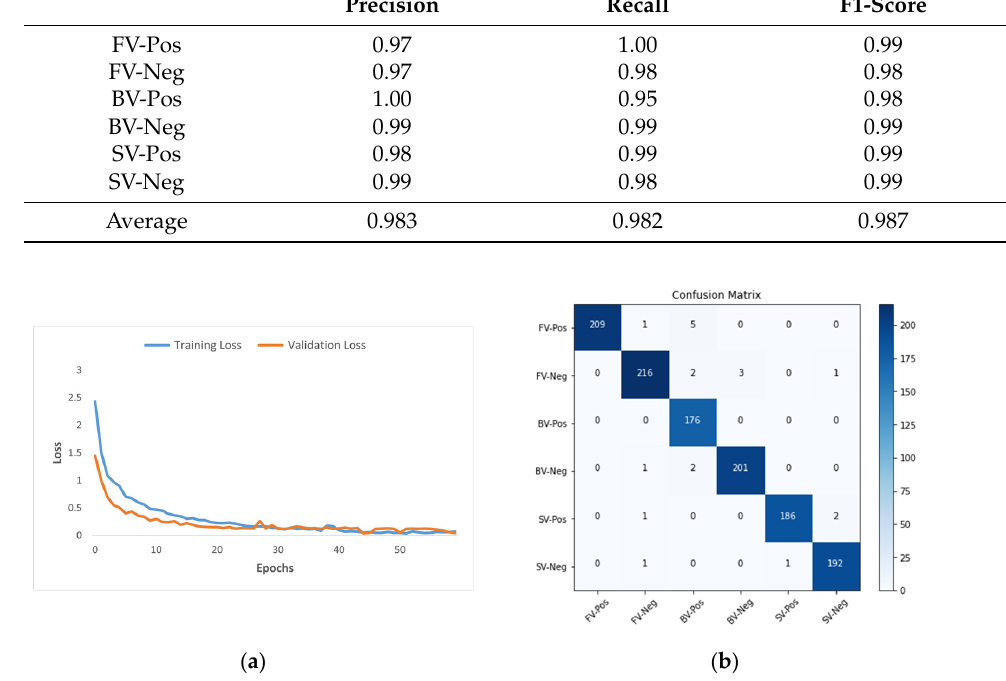
Table 18. Precision, recall, and F1-score for INRIA, ILIDS, and MSMT17 datasets.